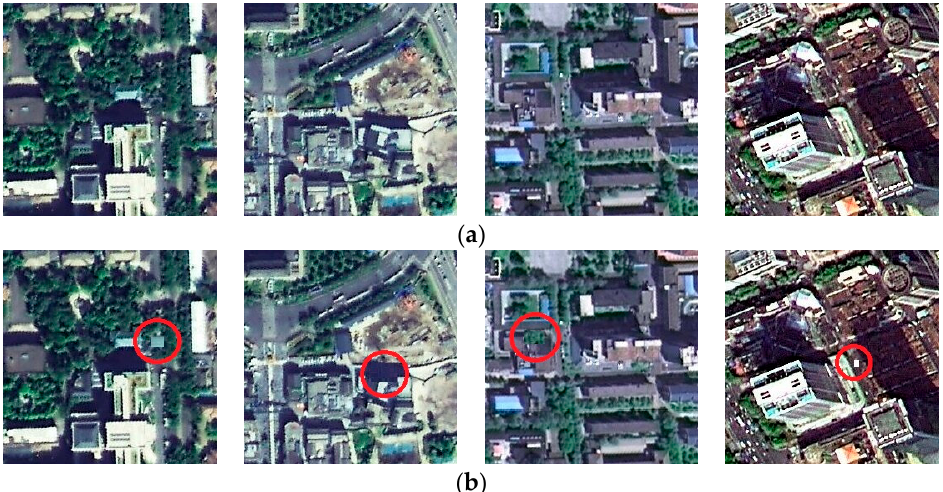
Figure 1. Examples of tampered HRRS images that have undergone different tampering techniques: ( a ) Original HRRS images, ( b ) corresponding tampered images.